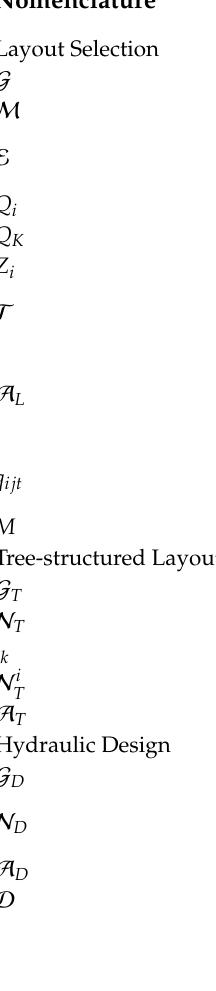
Table S1: Input data Benchmark proposed by Li and Matthew [34]. The exact x and y coordinates are not defined, however the length of the pipes is known, Table S2: Hydraulic design for the Benchmark proposed by Li and Matthew [34], Table S3: Input data Benchmark proposed by Moeini and Afshar [31], Table S4: Hydraulic design for the Benchmark proposed by Moeini and Afshar [31], Table S5: Input data for the manholes of Chic ó ’s sewer network (109 manholes), Table S6: Hydraulic design for the Benchmark Chic ó , Figure S1: Coe ffi cient of determination R 2 of the linear approximation of the cost function for each pipe in Chic ó case study after 25 iterations, Figure S2: Global fitness of the linear approximation of the cost in terms of the flow